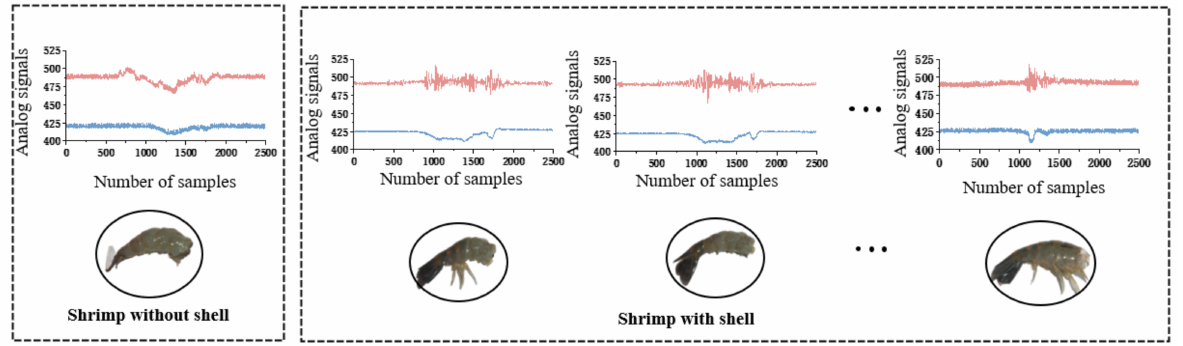
Figure 7. Plot of raw data of shrimp with and without shells.